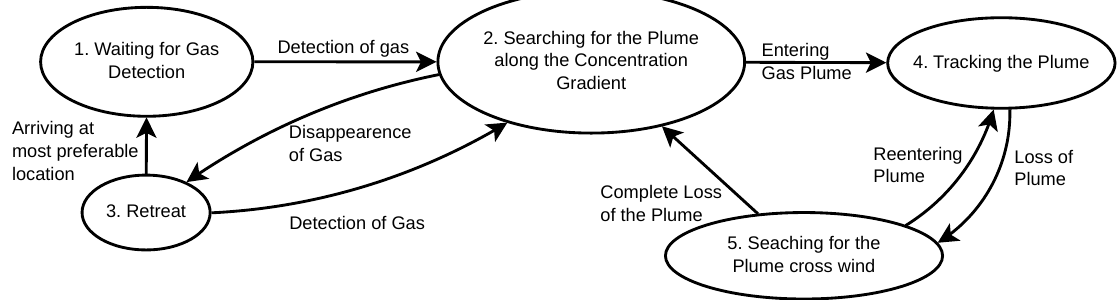
Figure 2. Flow chart of the Multiphase strategy proposed by Ishida et al.